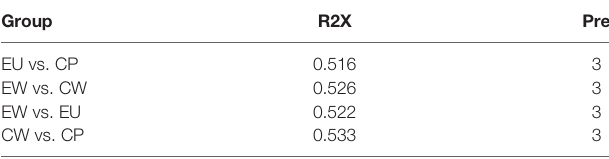
TABLE 1 | PCA validation parameters of various pairwise comparison groups.